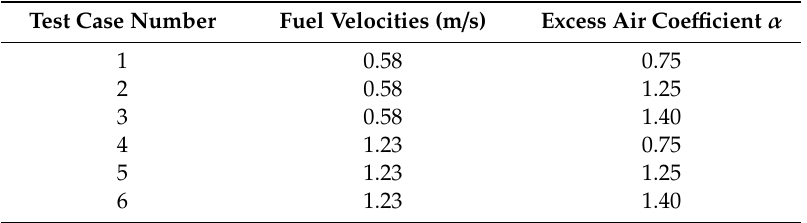
Table 2. Boundary conditions of six test